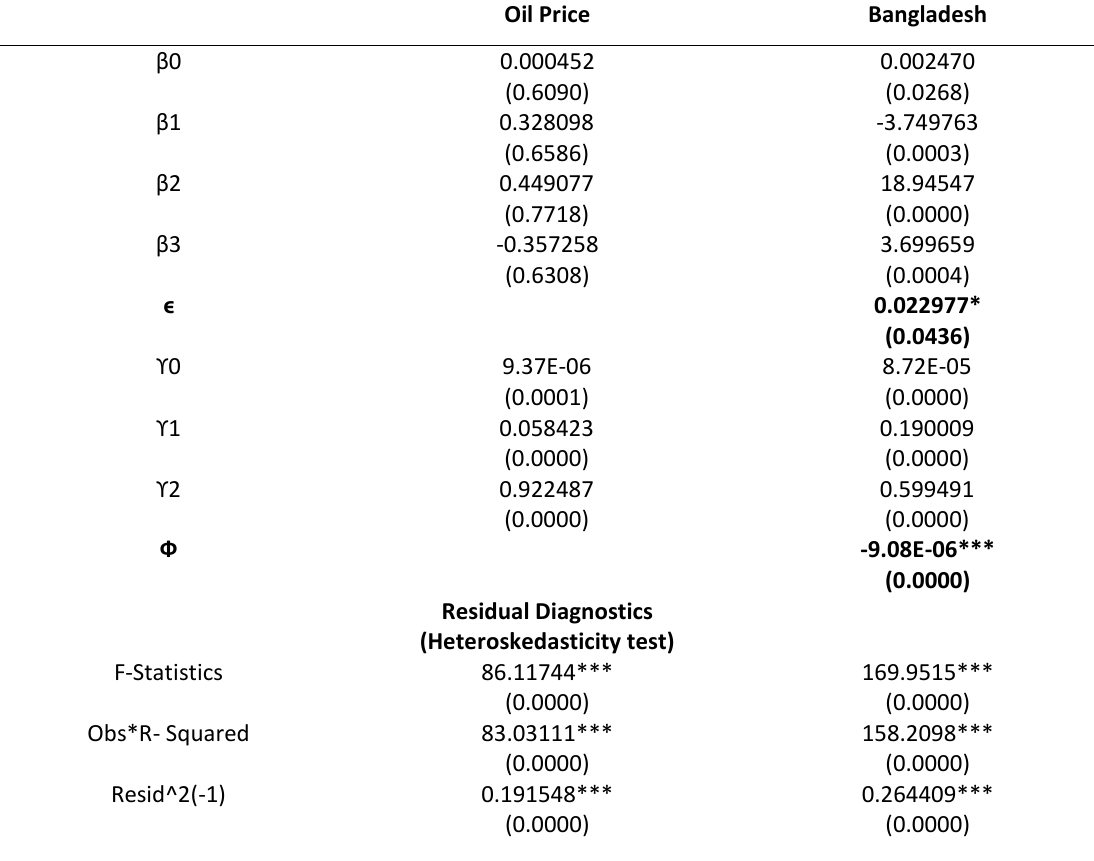
Table 5. Mean and Volatility spillovers from Oil Market Price to Bangladesh Equity Market estimated from an ARMA (1, 1)–GARCH (1, 1)–in–mean model (January 2004-June